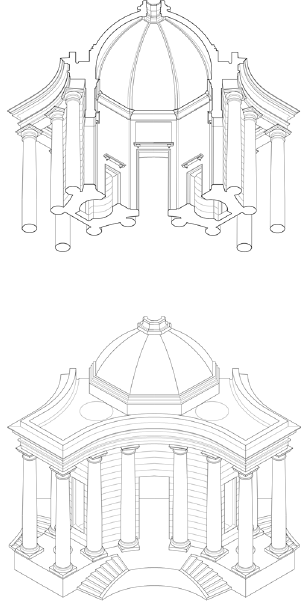
Figure 6. Top and bottom Axonometric cross